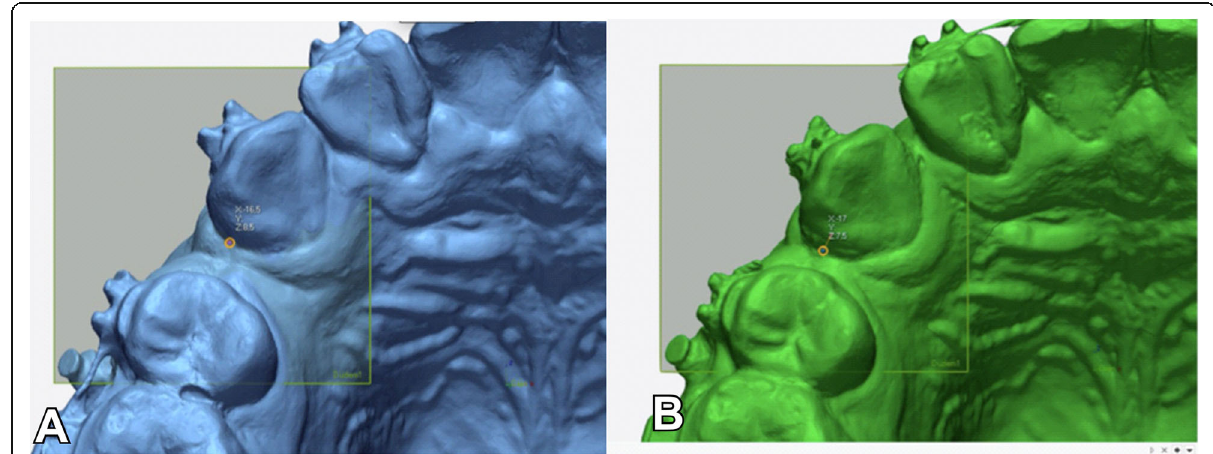
Fig. 4 The calculation of the retraction rate using the horizontal plane. A Marking the most distal point of the canine in the T0 model. B Marking the most distal point of the canine in the T3 model